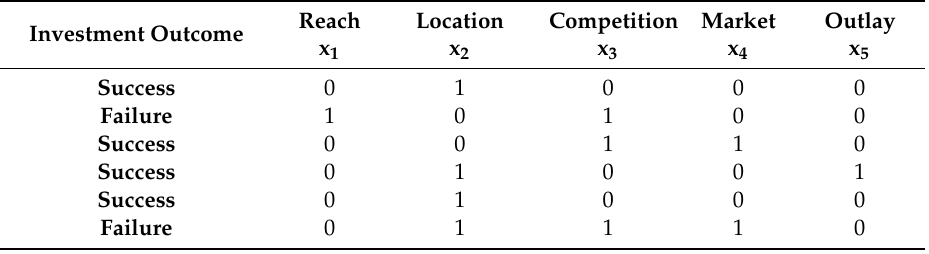
Table 2. An excerpt from the spreadsheet containing data used in the analysis.